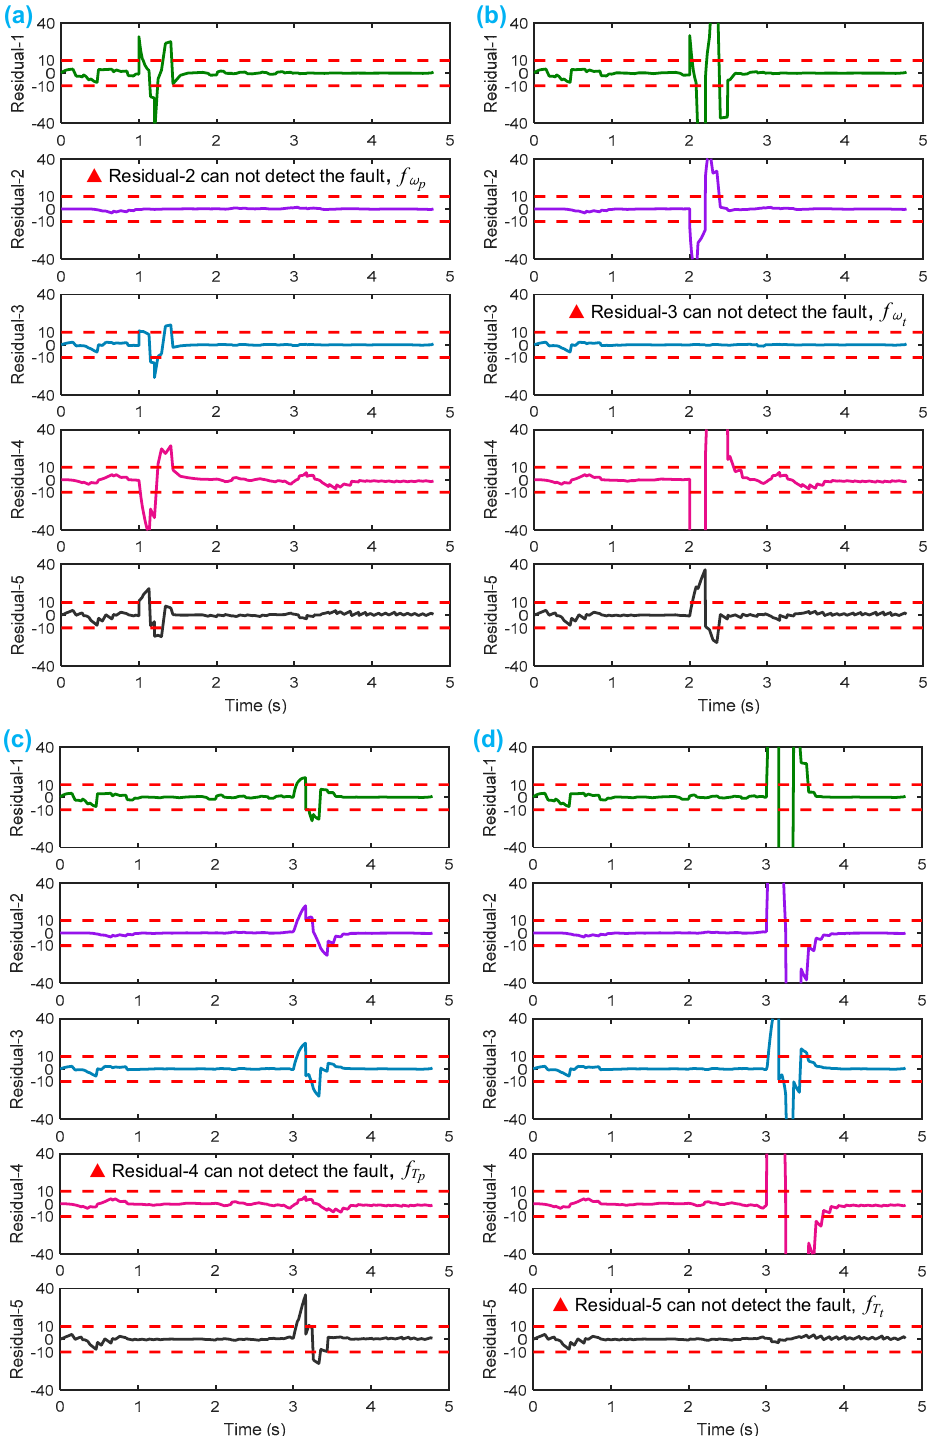
Figure 15. Responses of the five residuals for the HTC in a Honda CRV from Pohl’s experiment: ( a ) when fault 𝑓 (cid:3104) happens; ( b ) when fault 𝑓 (cid:3104) happens; ( c ) when fault 𝑓 (cid:3021)(cid:3043) happens; ( d ) when fault 𝑓 (cid:3021)(cid:3047) happens.